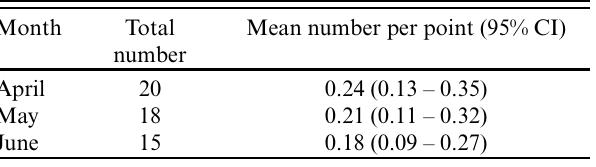
Buff-throated Partridge